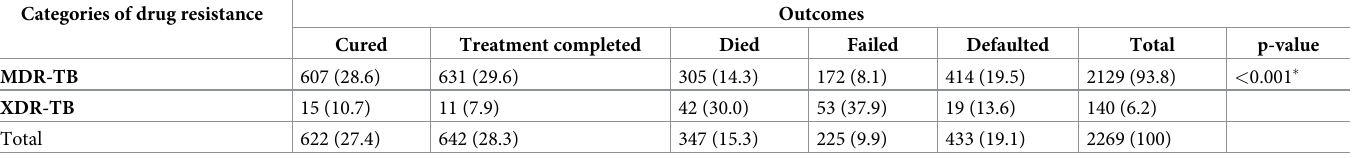
Table 3. Treatment outcomes among 2269 patients with MDR-TB and XDR-TB. Categories of drug